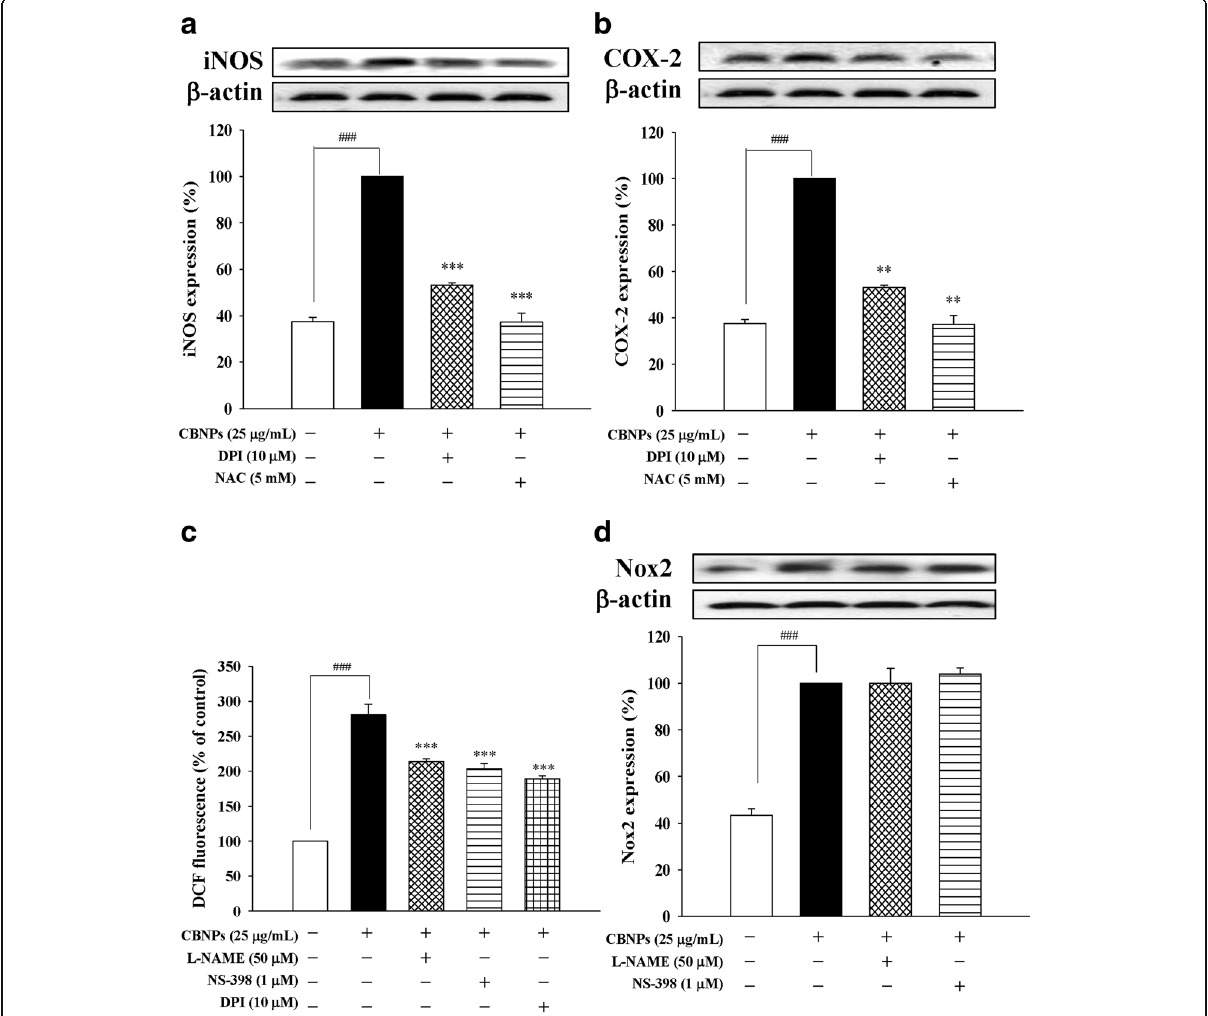
Fig. 5 Effects of DPI or NAC on CBNP-induced iNOS ( a ) and COX-2 ( b ) expression in A549 cells. c Effects of L-NAME, NS-398, or DPI on CBNP-induced ROS production in A549 cells. d Effects of L-NAME or NS-398 on CBNP-induced Nox2 activation in A549 cells. Cells were pretreated with DPI, NAC, L-NAME, or NS-398 1 h before addition of CBNPs (25 μ g/mL) for 24 h. ROS production was measured using H 2 DCF-DA staining and detected the DCF fluorescence by flow cytometer. Bars represent the mean±S.E.M. from six independent experiments. ### P <0.001 vs. control group (without any treatment). ** P <0.01, *** P <0.001 vs. CBNPs (25 μ g/mL)